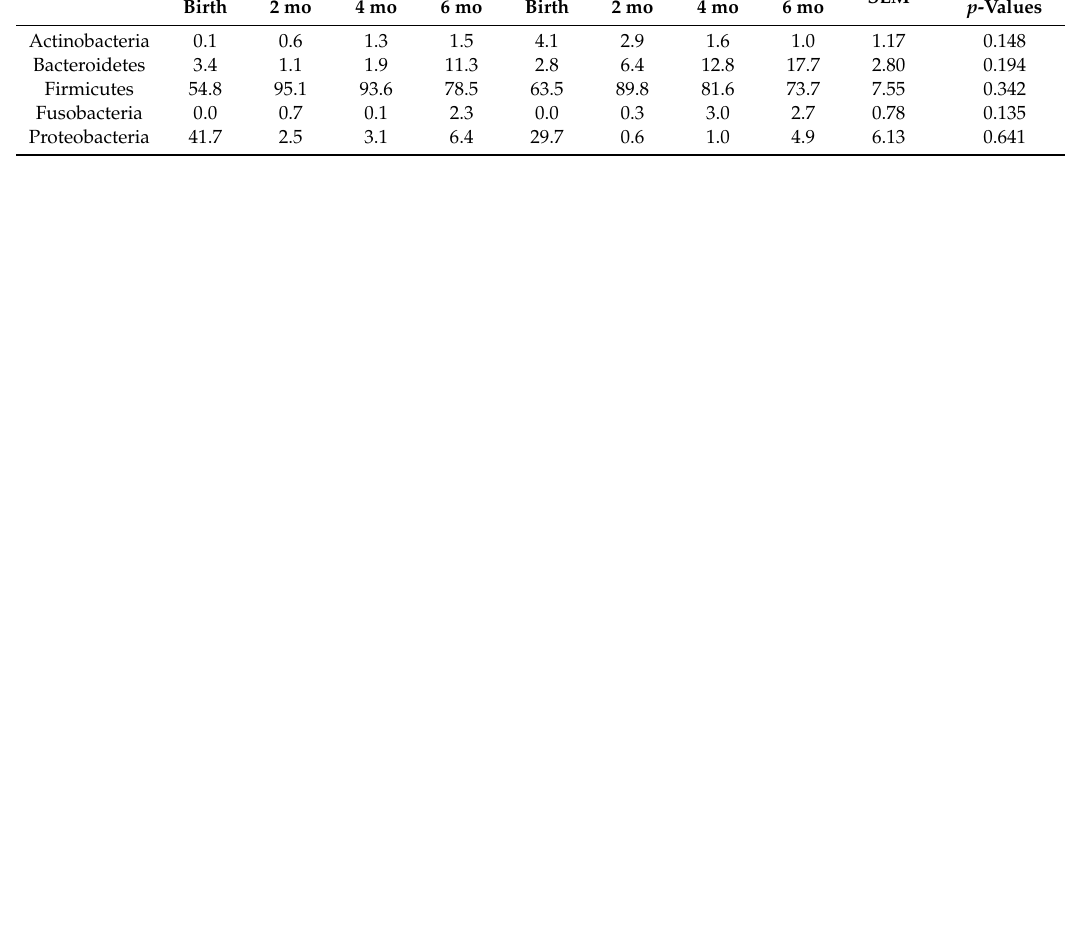
Table 4. Oral bacterial phyla of infants by age and duration of breast feeding (% of sequences). Exclusive Breast Feeding for at Least 4 mo ( n = Phyla